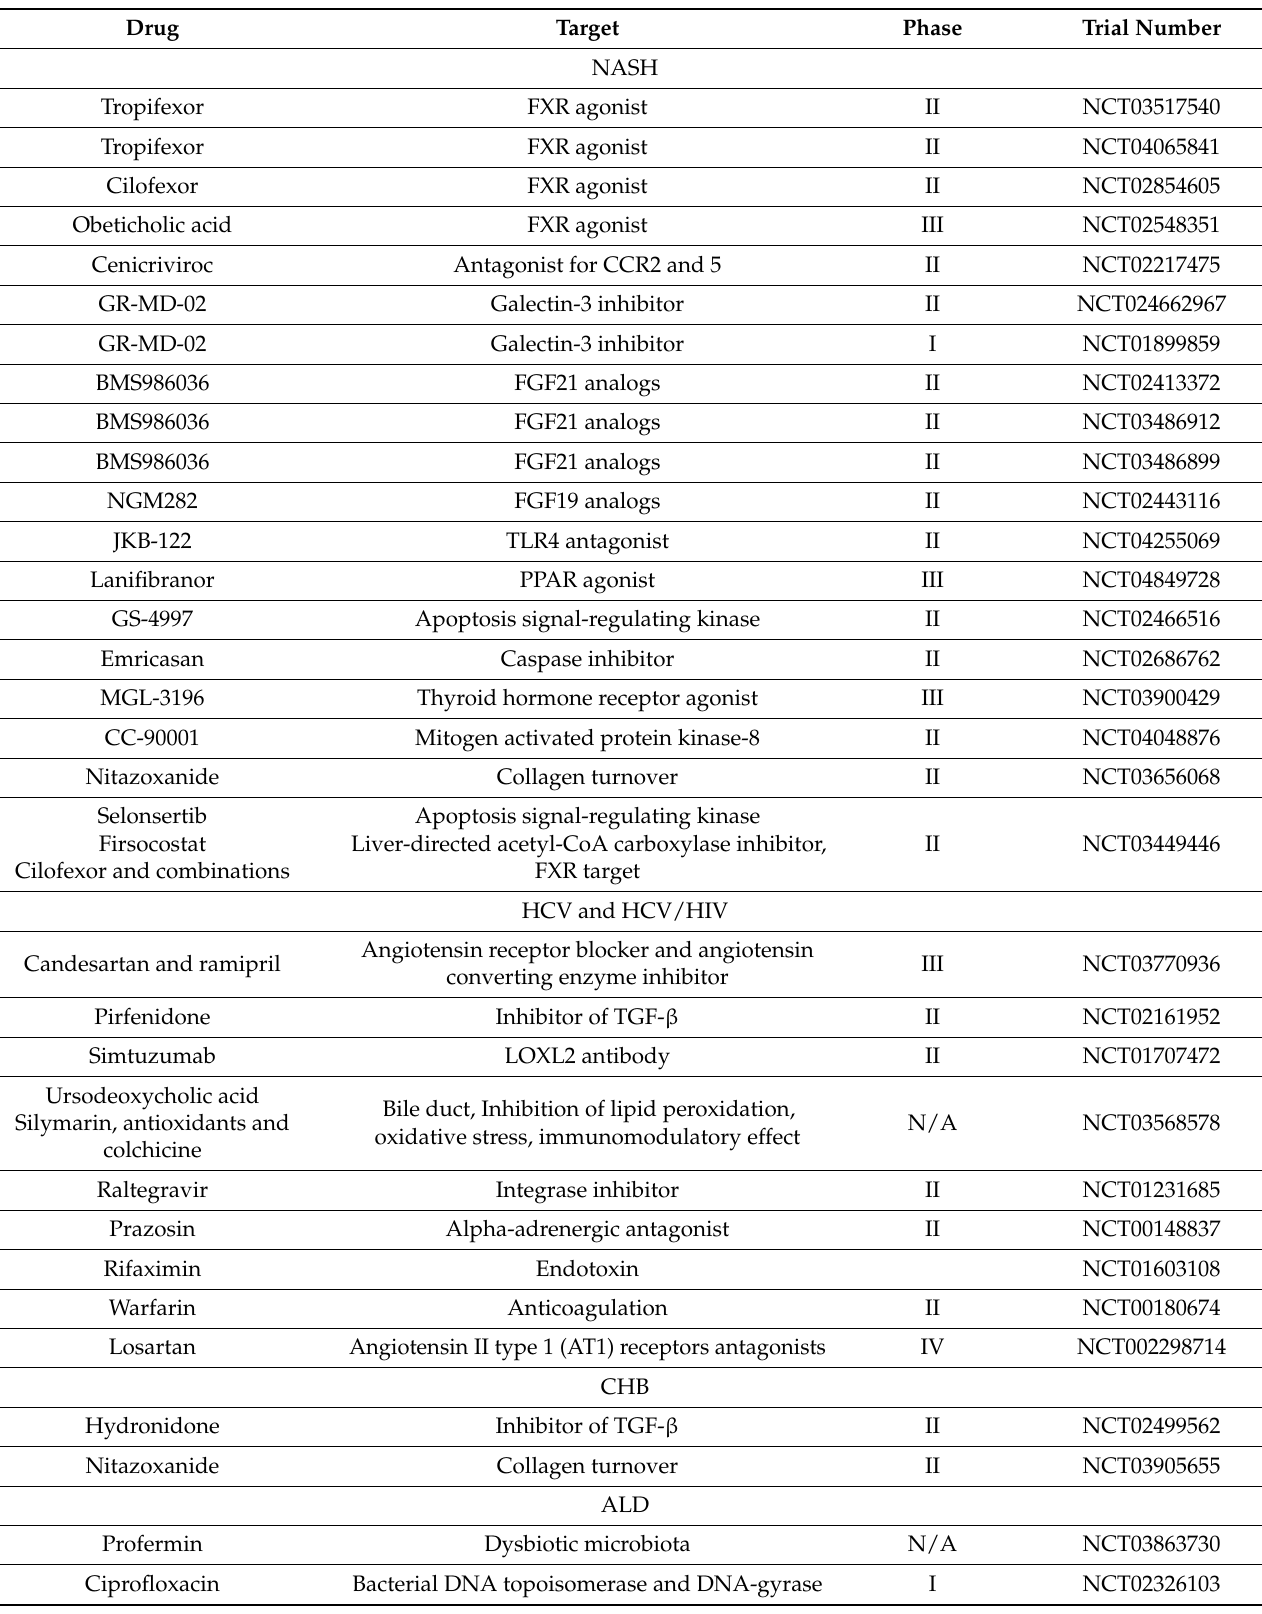
Table 2. Clinical trials for different etiology related